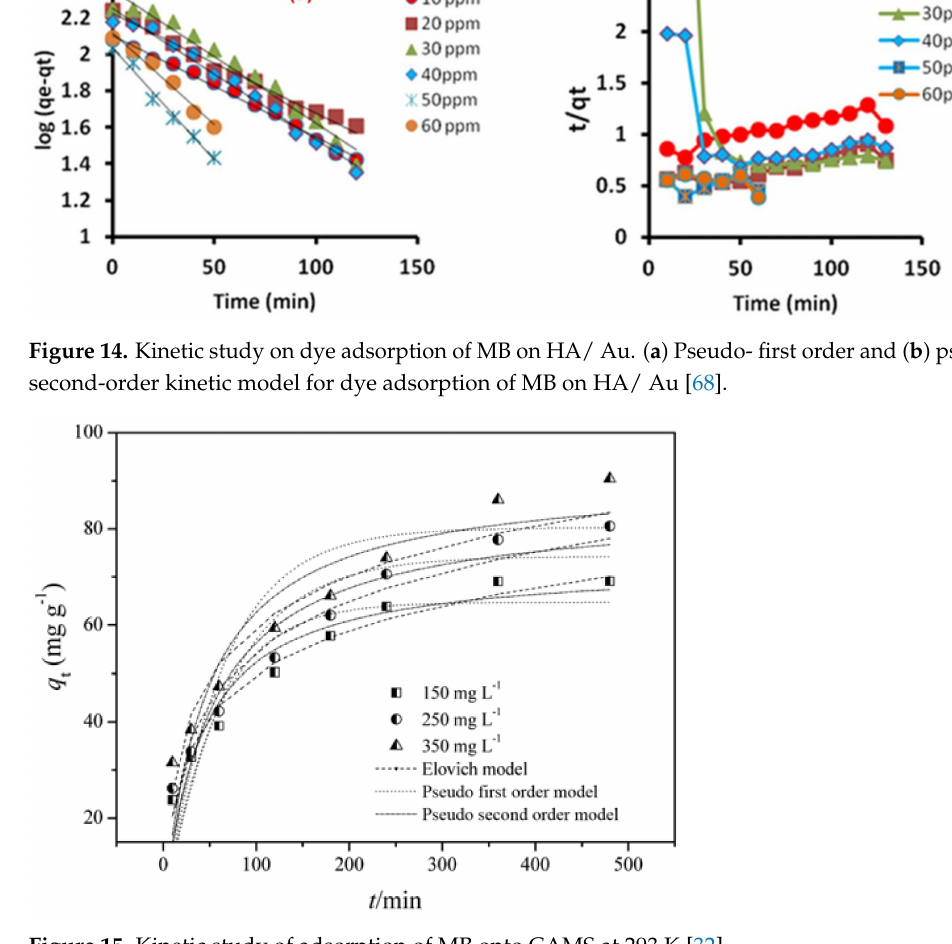
Figure 15. Kinetic study of adsorption of MB onto CAMS at 293 K